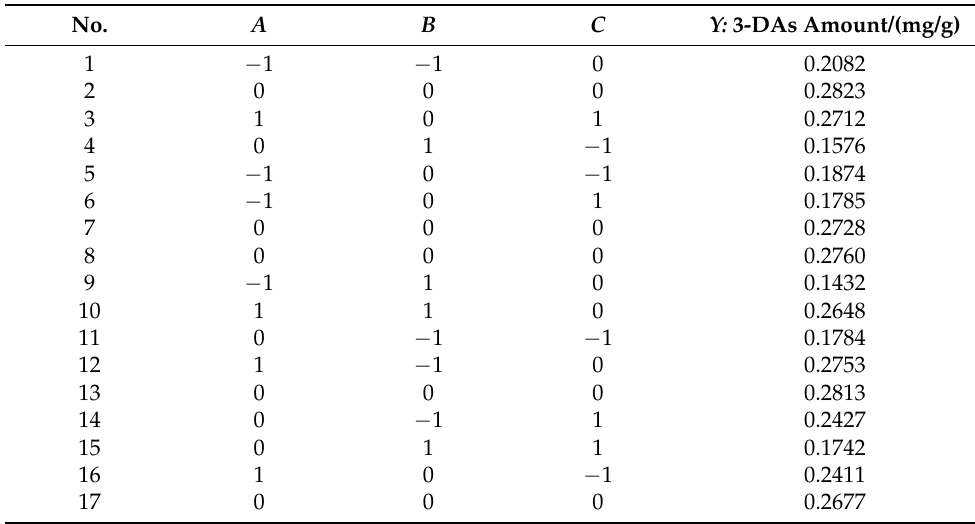
Table 2. Response surface analysis design and